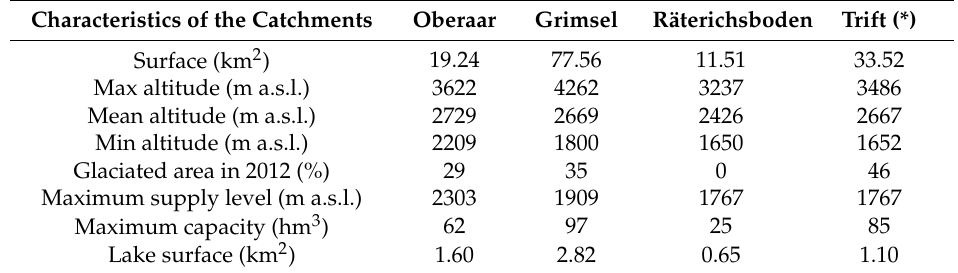
Table 1. Topographic data and main dimensions of the catchments and reservoirs analyzed in this study. Characteristics of the Catchments Oberaar